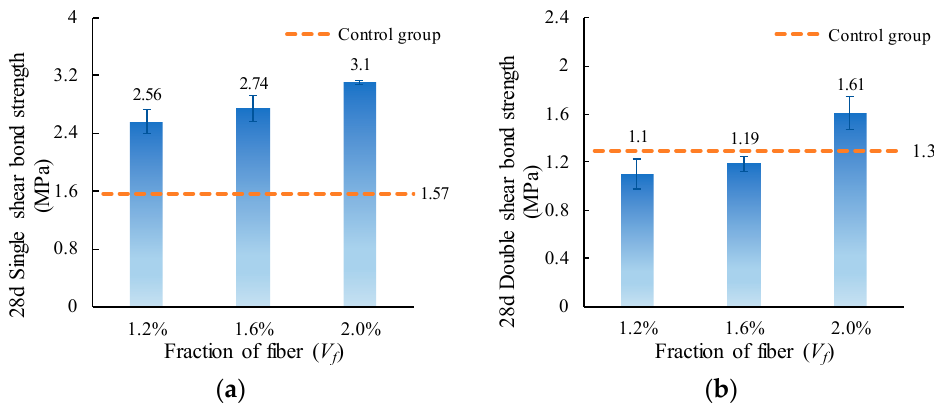
Figure 10. ( a ) Single shear bond strength and ( b ) double shear bond strength of specimens with varying fiber volume fraction ( V f ).